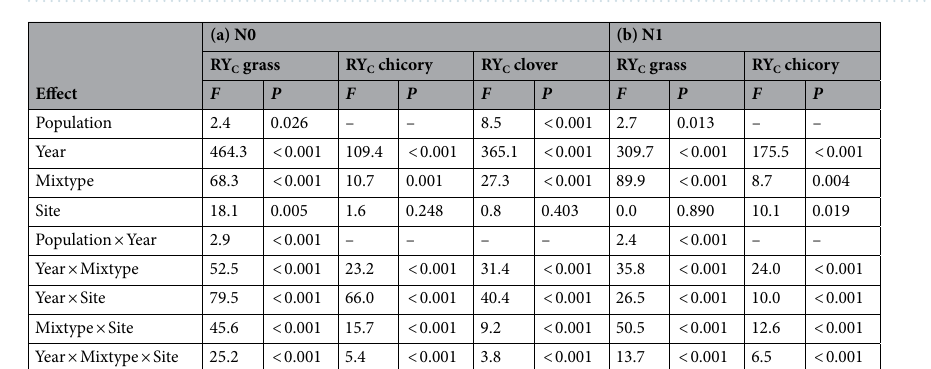
Figure 2. Temporal trends of diversity effects ( a ) complementarity effect (CE), ( b ) selection effect (SE) and ( c ) net biodiversity effect (NE) for different mixture types (TL: clover-grass mixture, TC: clover-chicory mixture, TLC: clover-grass-chicory mixture) at both study sites (site R, site D) using either unfertilized (N0) or fertilized (N1) non-leguminous pure stands as a reference. Given values are model predictions with 95% confidence intervals ( n = 64). Pure stand and mixture yield of grass, chicory and clover can be found in Supplementary Table S4.